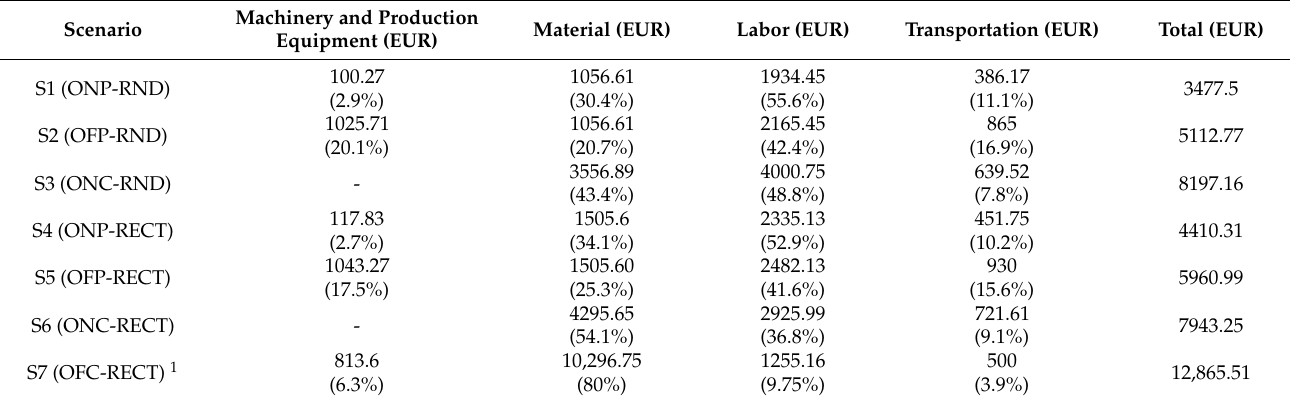
Table 5. Cost comparison of the scenarios per